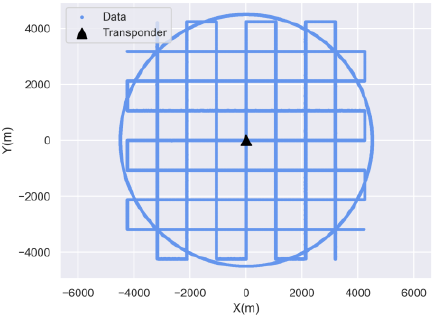
Figure 5 . Spatial position.